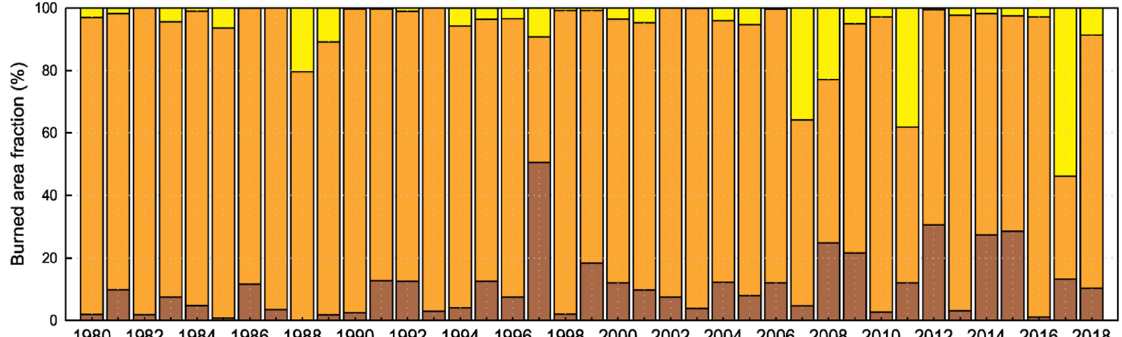
Figure 4. Annual evolution of the fraction of annual burned area recorded before (brown bars, Jan-Jun months with increasing trend, ρ -value = 0.0052), during (orange bars, Jul-Sep months with decreasing trend, ρ -value = 0.0011) and after (yellow bars, Oct-Dec months with no trend, ρ -value = 0.0429) the most critical months for wildfire incidence in the period of 1980–2018.